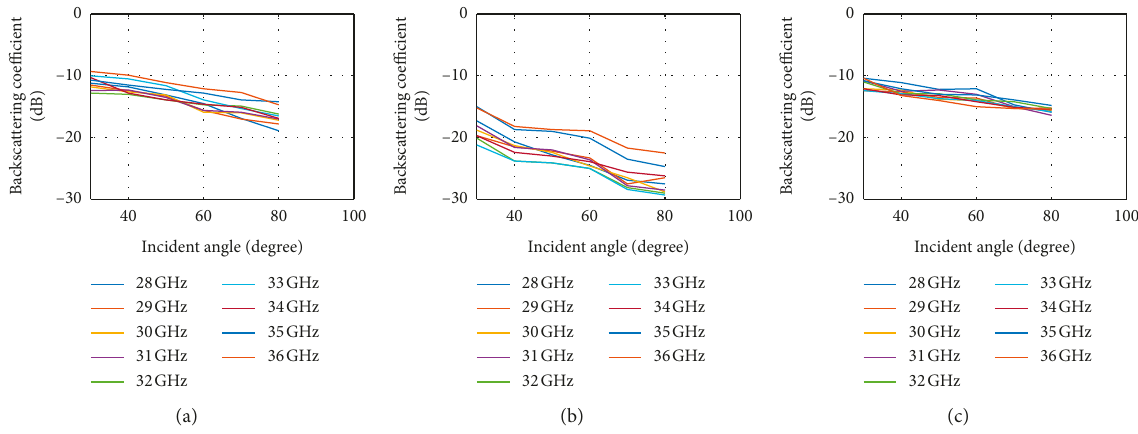
Figure 12: Angular patterns of measured backscattering coefficients of the pine tree in (a) HH, (b) HV, and (c) VV polarizations from 28GHz to Table 5: Dynamic range of measured backscattering coefficients of pine and banyan trees in HH, HV, and VV polarizations from 30 to 80 degrees. Frequency (GHz)